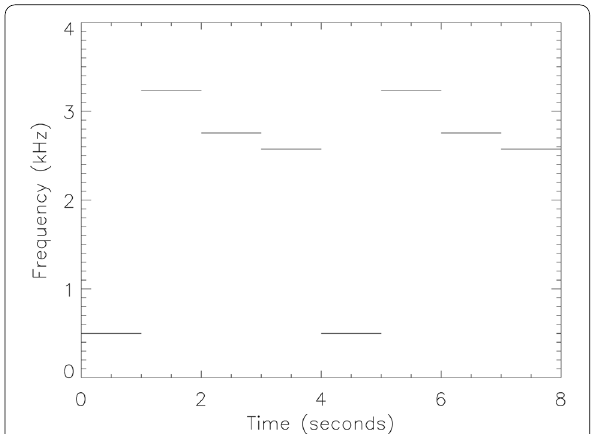
Fig. 13 Pulses triggered by HAARP during the case 4 when DEMETER is in the Northern hemisphere